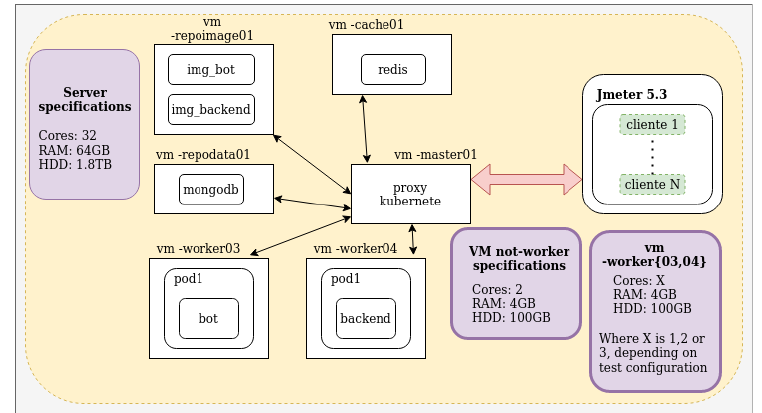
Figure 10. Deployment of the applications on two